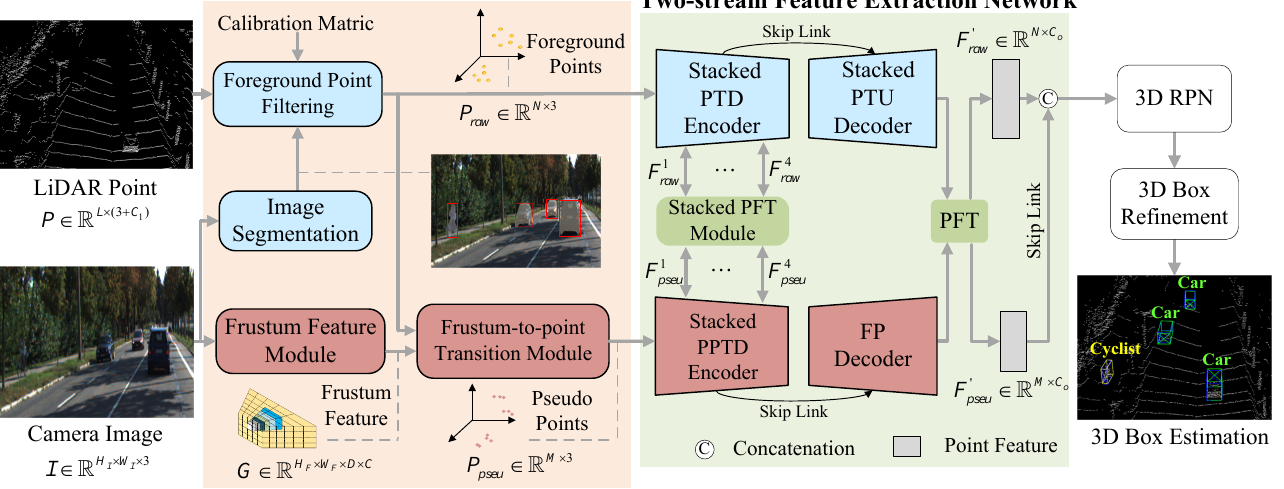
Figure 2. Illustration of the architecture of PTA-Det. It is composed of four parts: (1) Pseudo Point Cloud Generation Network for generating the coordinates and features of PPCs, (2) Two-stream Feature Extraction Network for learning point-based intra-modal and inter-modal features, (3) 3D RPN for proposal generation, (4) 3D Box Refinement for rectifying